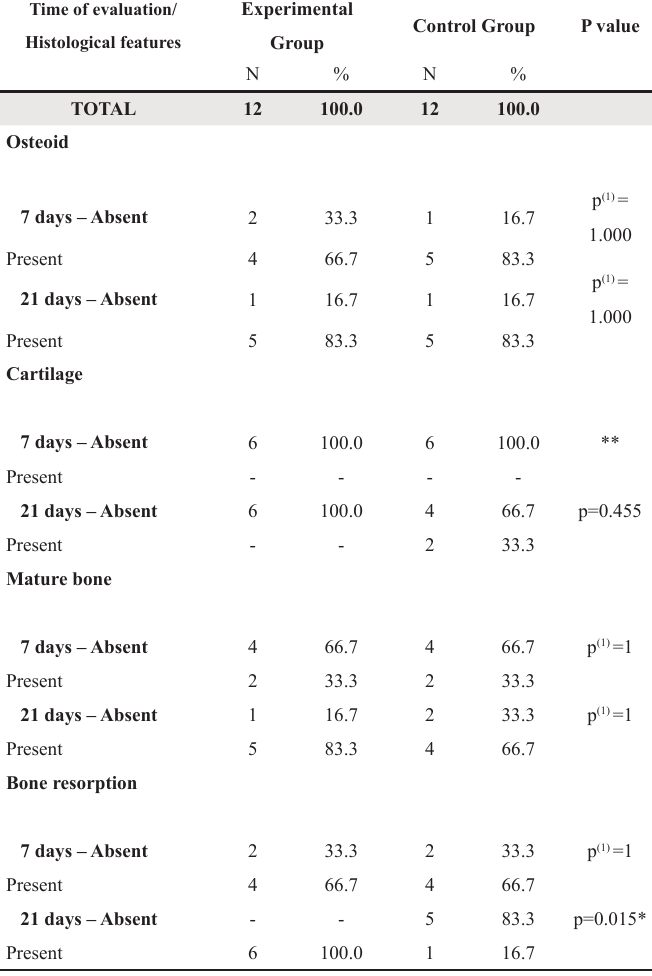
TABLE 2 – Evaluation of the histological features of the final phase of repair according to group and time of evaluation.